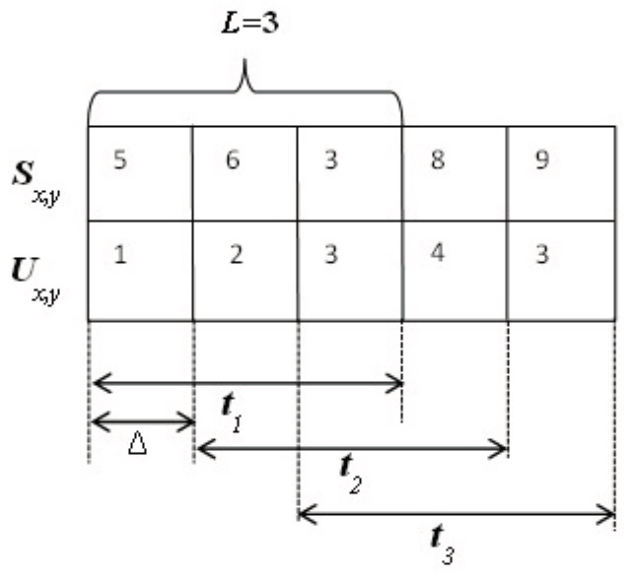
Figure 2. Application of the time-window mechanism in managing and recording